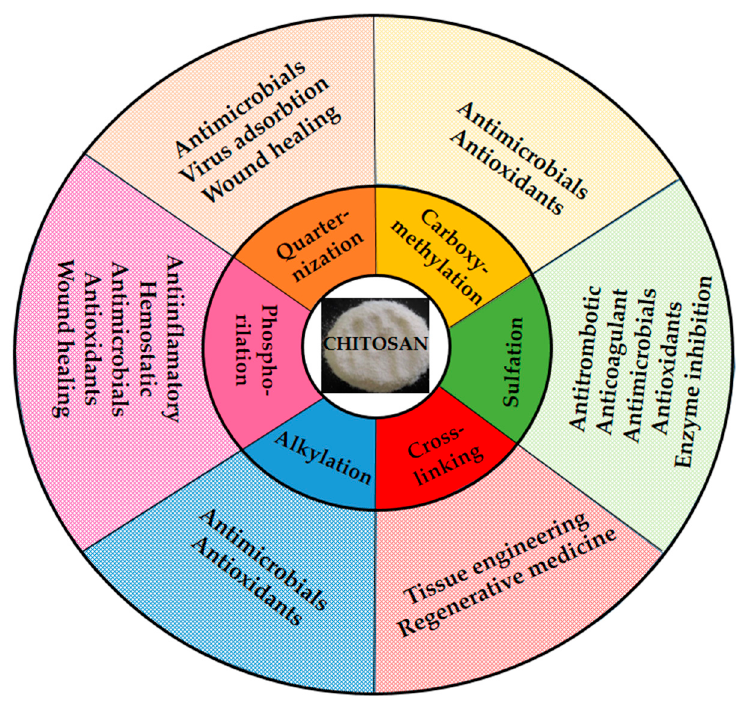
Figure 3. Applications of chitosan